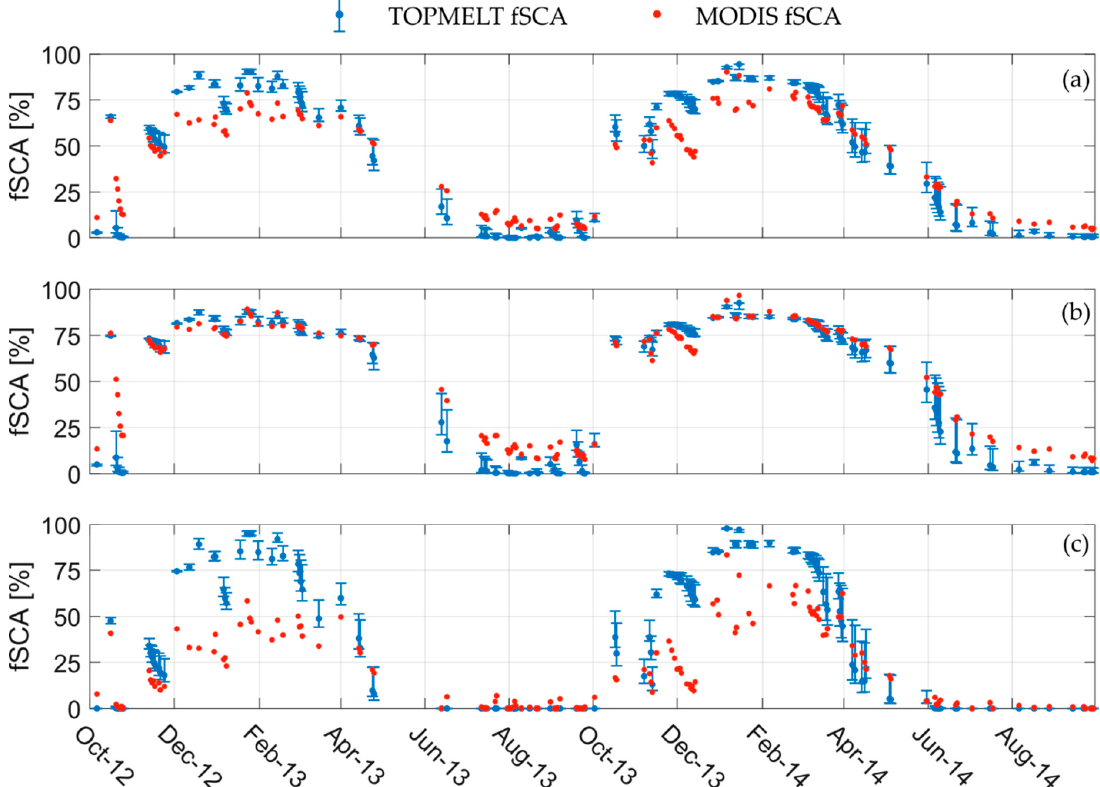
Figure 5 : Predictive fractional SCA uncertainty range compared with MODIS-based fractional SCA, over the period 01 October 12 to 30 Sepember 14 considering ( a ) total catchment, ( b ) only forest free areas and ( c ) only forested areas.